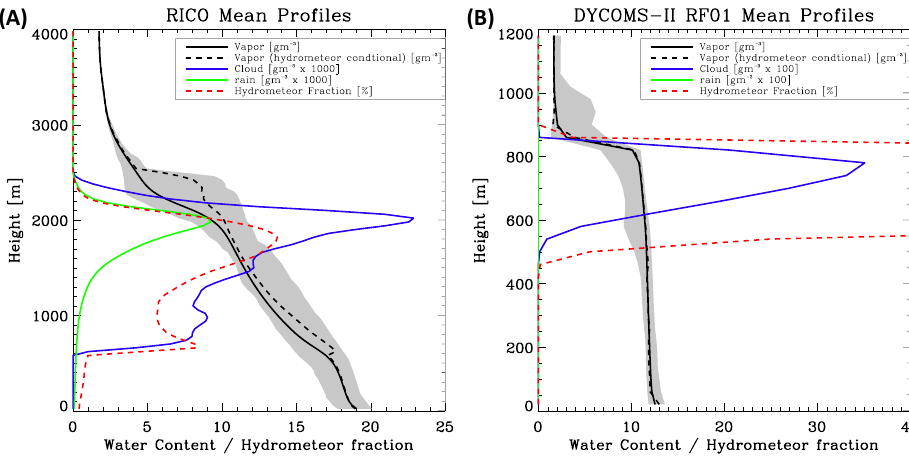
Figure 3. Mean profiles for the RICO (a) and DYCOMS-II RF01 (b) simulations. The solid black line shows the mean vapor profile, the dashed black line shows the “in-cloud” conditional mean vapor profile, and the gray shading shows the range of the water vapor density. Cloud and rain water are shown in blue and green respectively. The dashed red line shows the fraction of atmosphere filled with hydrometeors at each